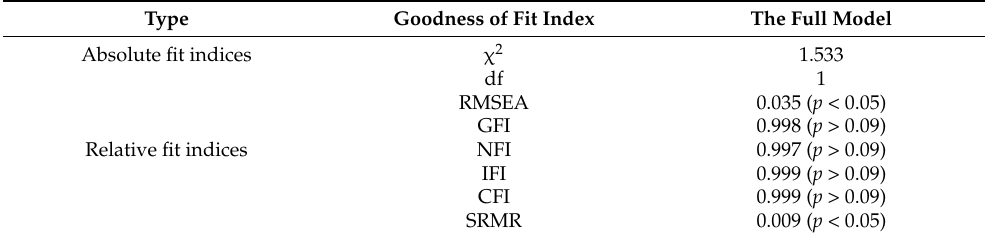
Table 3. The Goodness-of-Fit index of structural equation modeling for the hypothesized model.